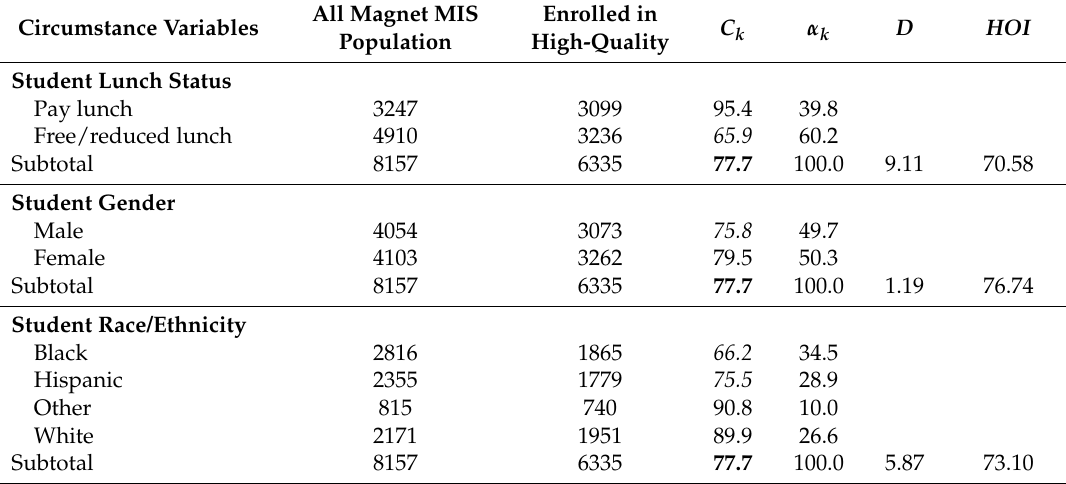
Table 4. Opportunity to be enrolled in a high-quality magnet middle school at